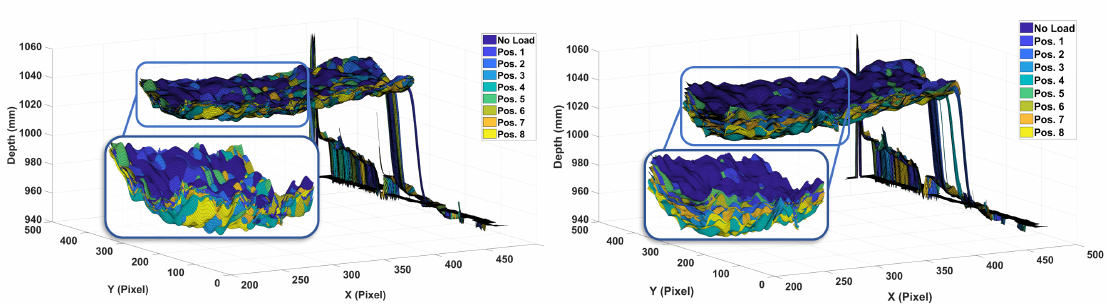
Figure 13. Wing deflections due to ( Left ) 2.45 N and ( Right ) 14.71 N loads applied on distinct positions of the